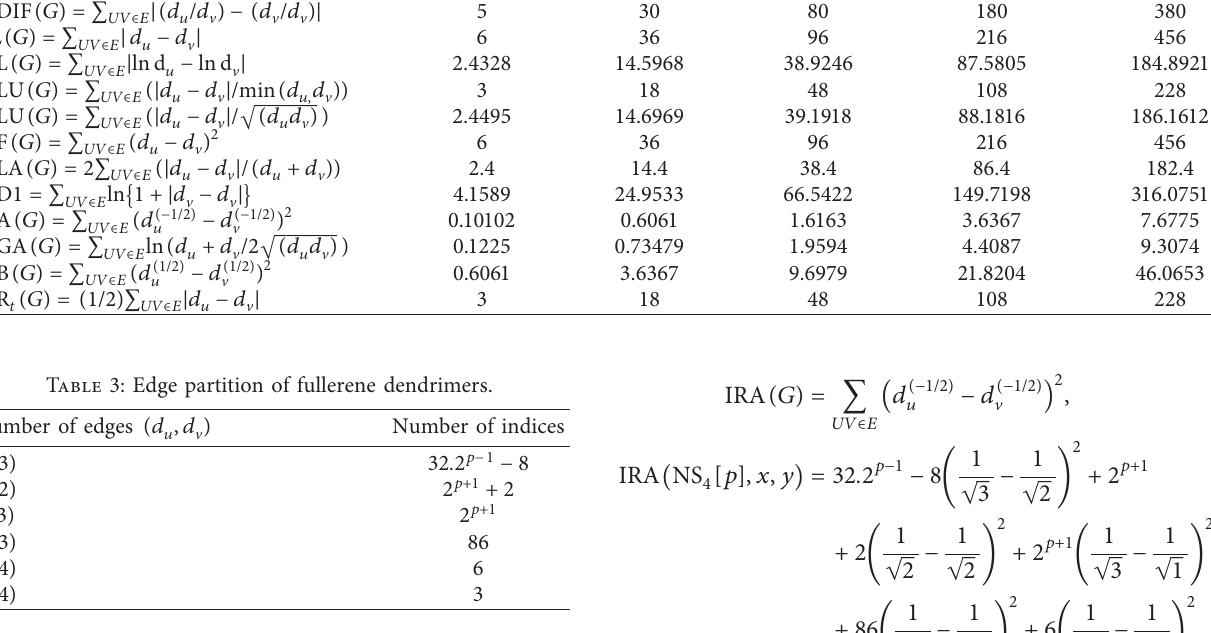
Table 2: Irregularity indices for nanostar dendrimer D